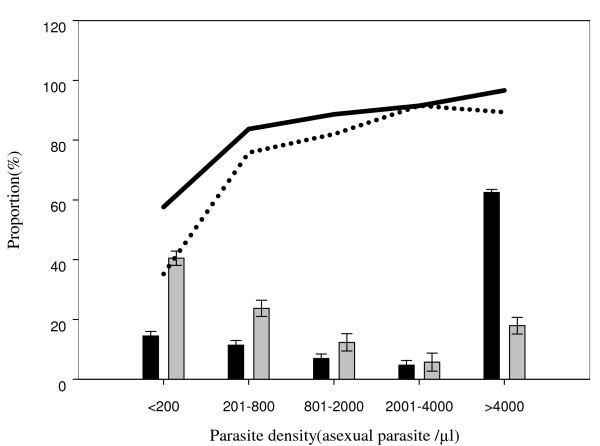
Overall sensitivity of RDTs by parasite density for blood smear positive samples in the longitudinal study and CSS in Korogwe and Muheza districts. Bars represent proportion of cases with positive blood smear results by different categories of parasite density, asexual parasites/μl (black bars = longitudinal study, n = 3793; and grey bars = CSS, n = 1045); Solid line = sensitivity of RDTs in the longitudinal study and dotted line = sensitivity of RDTs in the cross-sectional surveys (CSS)